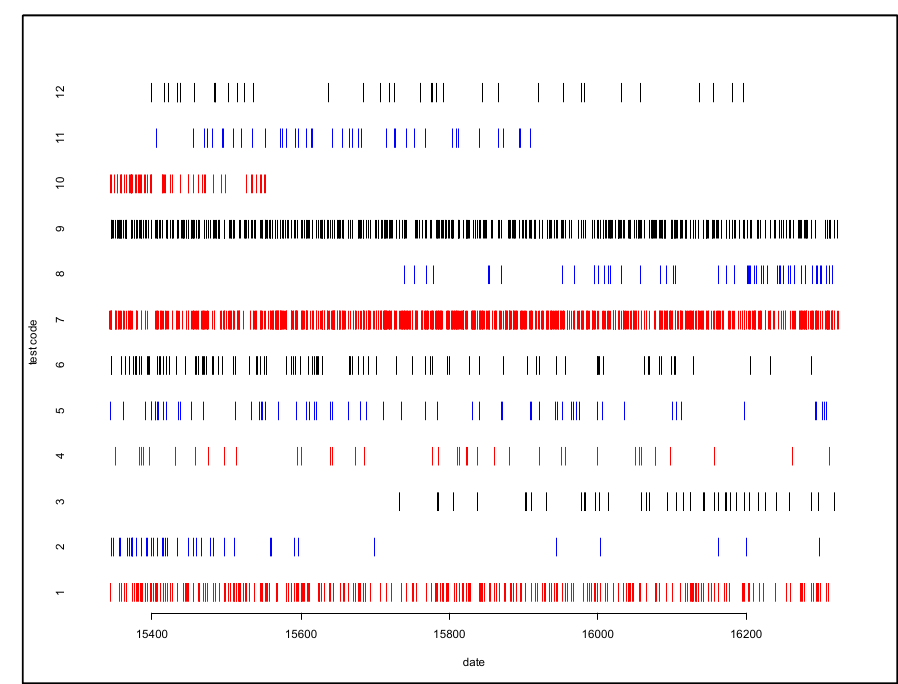
Figure 3. Lab test code used for positive hepatitis C reports by time for lab test codes with more than 30 reports. Each row represents a different lab test code, with vertical bars represent when reported cases occurred.